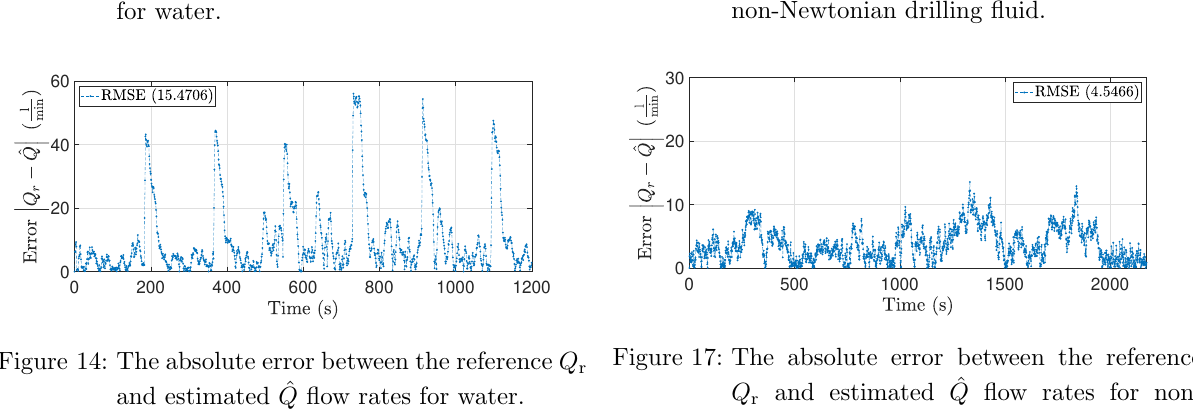
Figure 16: The estimated Fanning friction factor ˆ f for non-Newtonian drilling fluid.